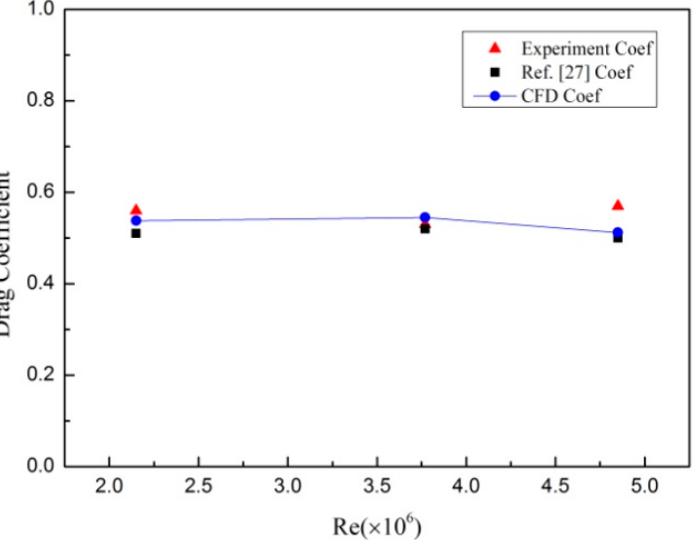
Figure 6. Comparison of the drag coefficient between simulations and experiments and previous simulations.